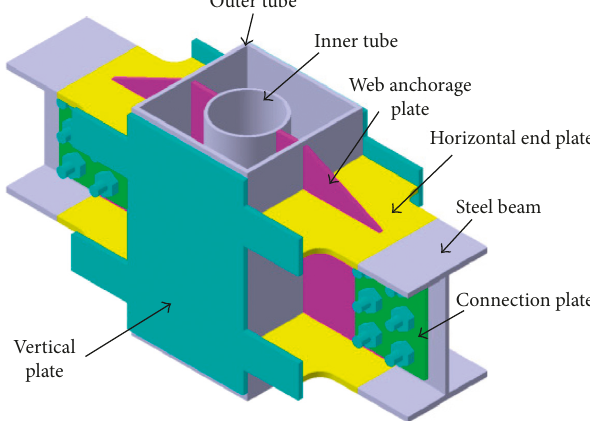
Figure 1: Construction of joint